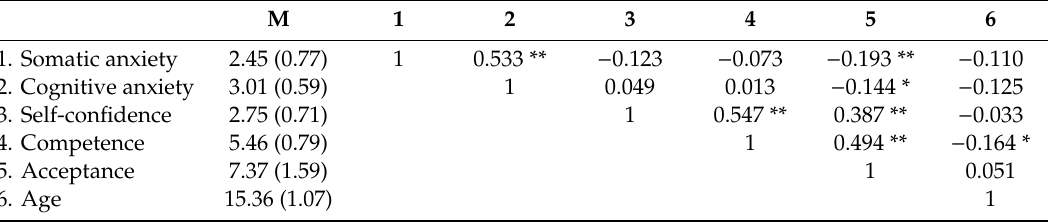
Table 5. Correlational analysis between resilience dimensions and anxiety